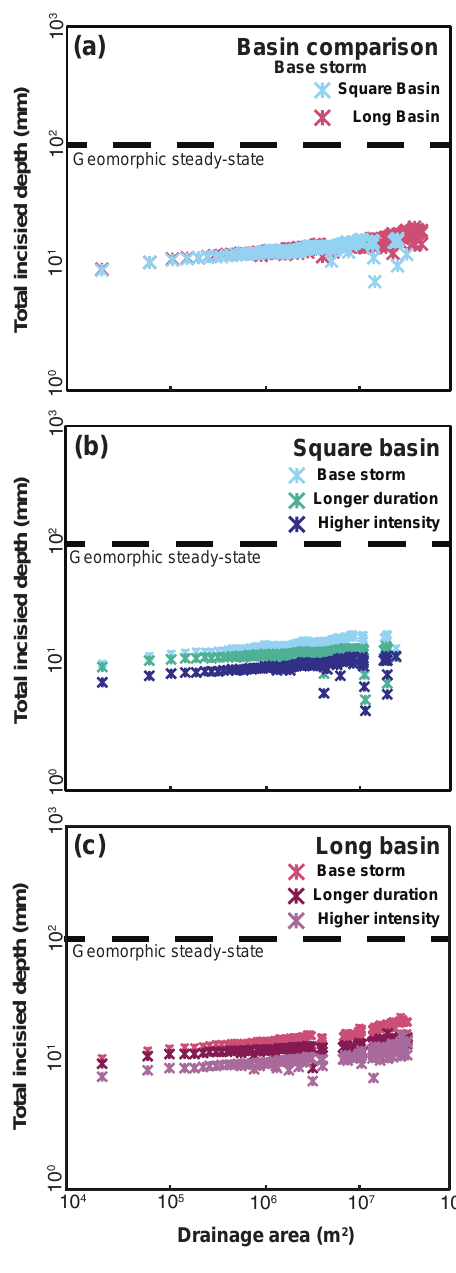
Figure 11. DetachmentLtdErosion output for all storms described in Table 4. Incision depth was taken after 10 years of modeled storms from the OverlandFlow component for all grid locations. The average incision depth was plotted at each drainage area: panel (a) shows incision depth versus drainage area for both the square and long basins after 10 years of the base storm; panel (b) shows total incision results from the square basin for all three pre- cipitation events after 10 years; and panel (c) shows total incision results from the long basin for all three precipitation events after 10